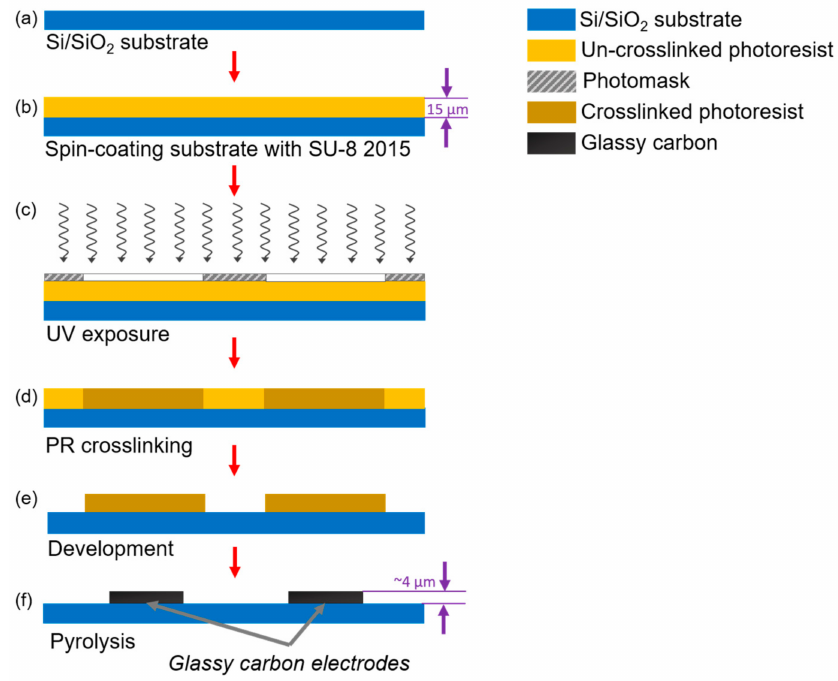
Figure 1. Standard photolithography process followed to fabricate castellated interdigitated electrode array. Here, ( a ) a silicon wafer is used as a substrate for the structures. ( b ) A spin coating process is carried out to deposit a 15 µ m layer of PR. Then, ( c ) the electrodes’ geometry is patterned through a photomask using UV light. ( d ) A hot bake is used to crosslink unexposed PR. ( e ) The crosslinked material is then developed using a PR developer solution; finally, ( f ) the crosslinked PR is pyrolyzed at 900 ◦ C to release non-carbon elements from the structure and obtain the glassy carbon electrodes.